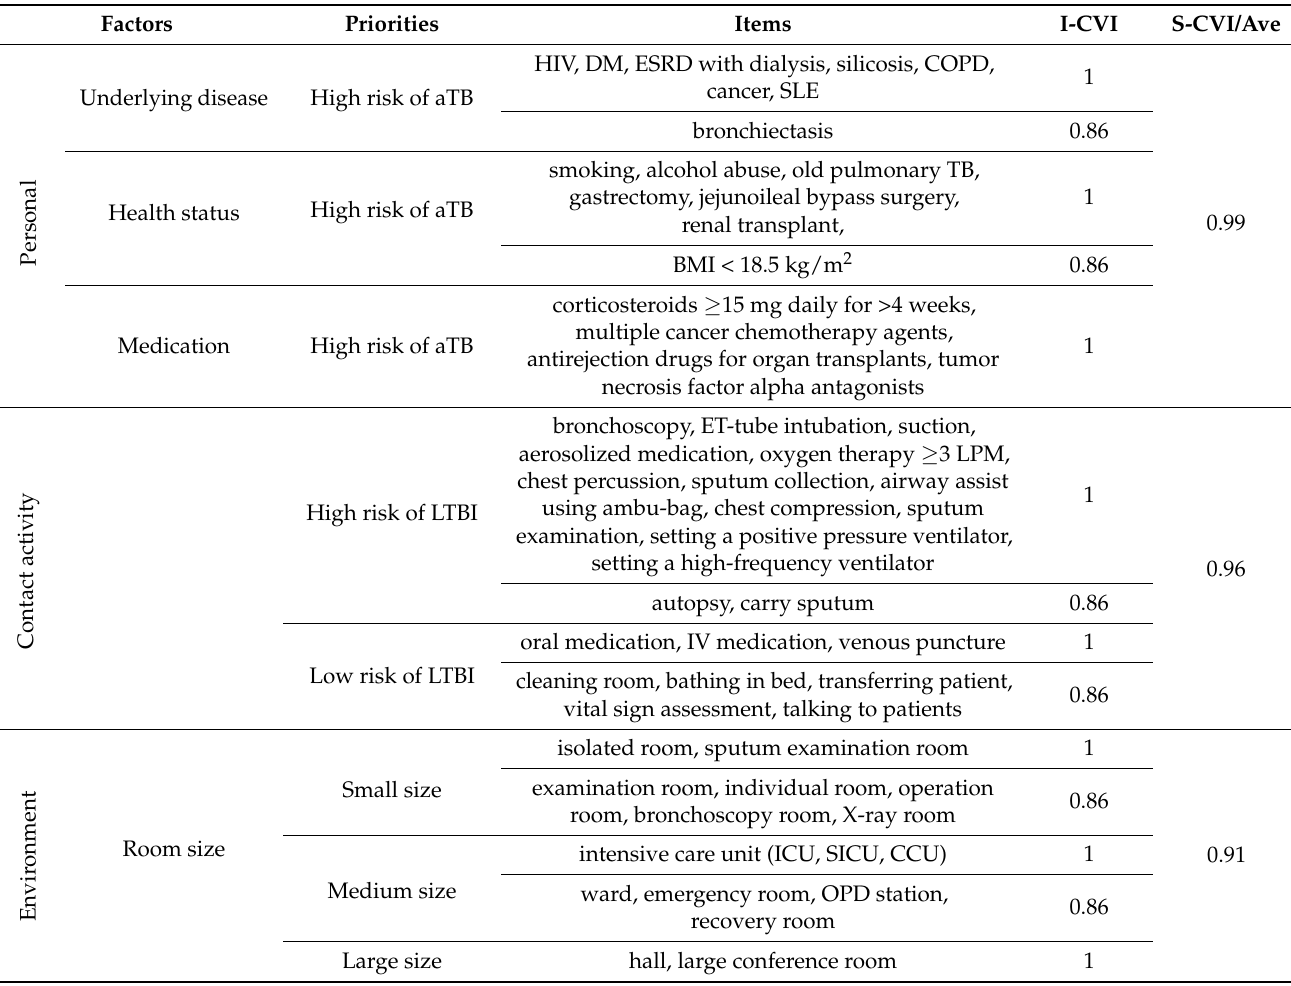
Table 2. Content validity of the Modified Self-Assessment (MSA)